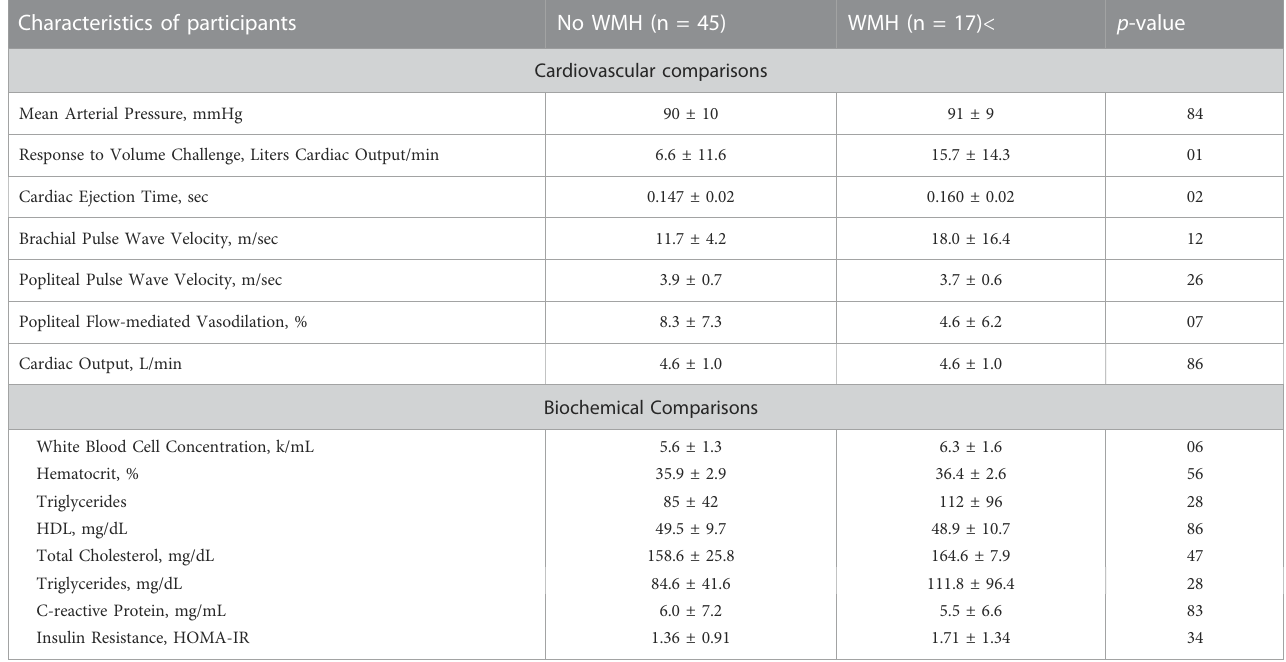
TABLE 2 Comparisons of cardiovascular and biochemical observations between women with and without evidence of white matter hyperintensities. Data are presented as mean ± standard deviation or frequency. Characteristics of